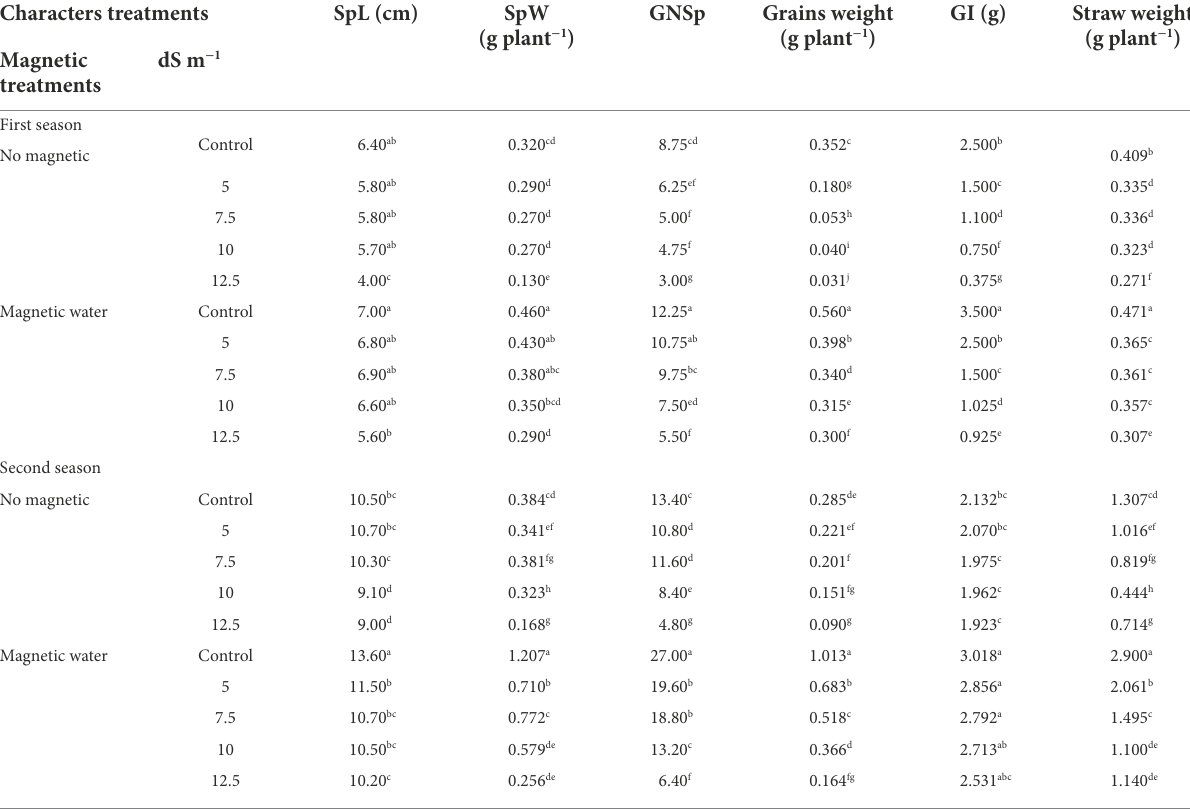
TABLE 7 Effect of seawater stress levels, magnetic treatment, and their interactions on yield attributes of wheat plants during the first and second growing seasons. Characters